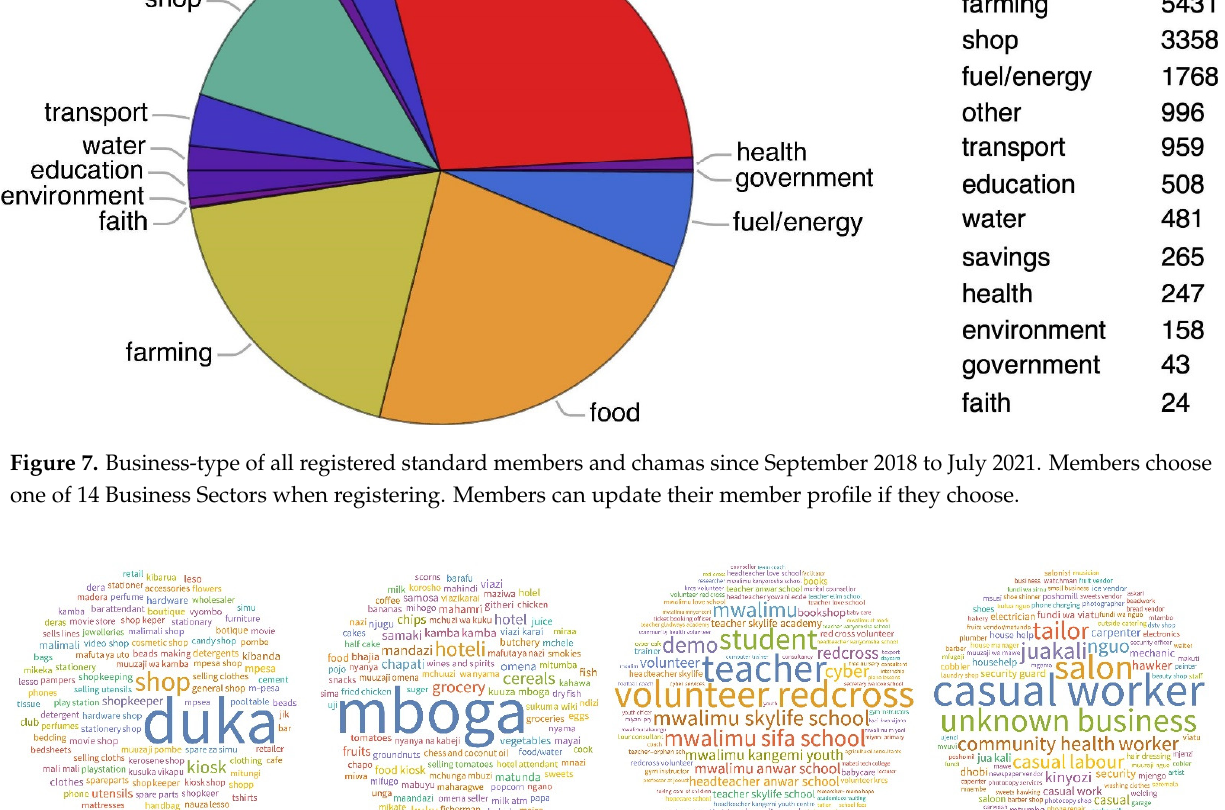
Figure 7. Business-type of all registered standard members and chamas since September 2018 to July 2021. Members choose one of 14 Business Sectors when registering. Members can update their member profile if they choose.